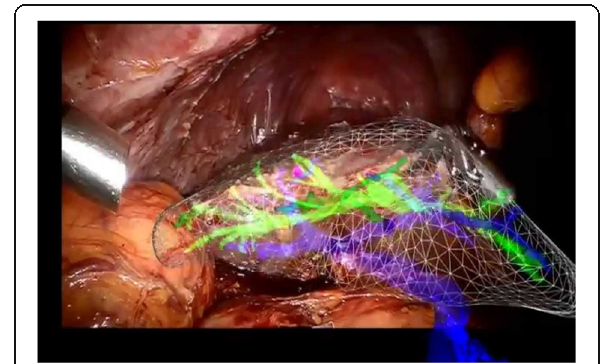
Fig. 7 Hepatic surgery using